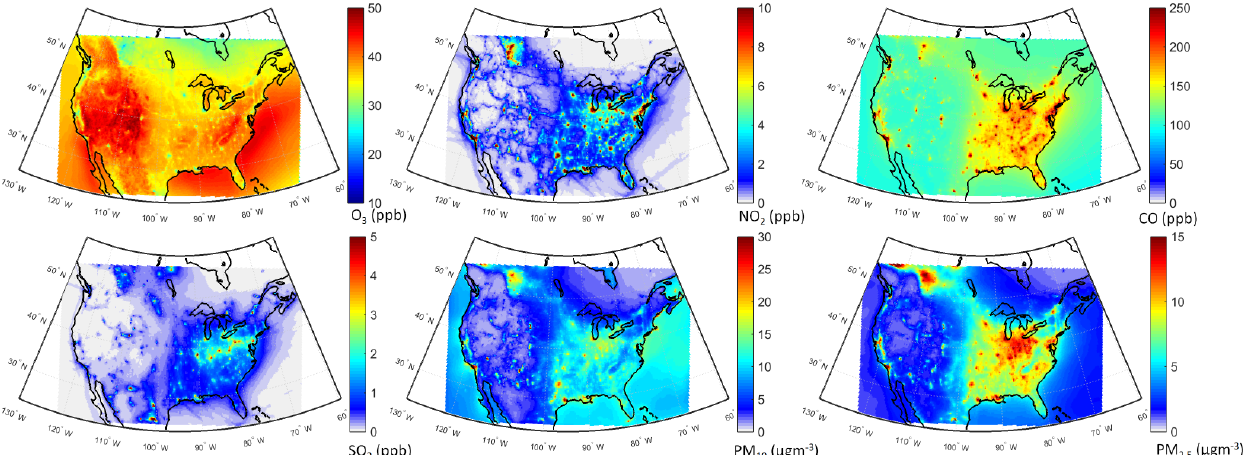
Figure 4. Multi-model mean air pollutant levels over North America as simulated in the base case.